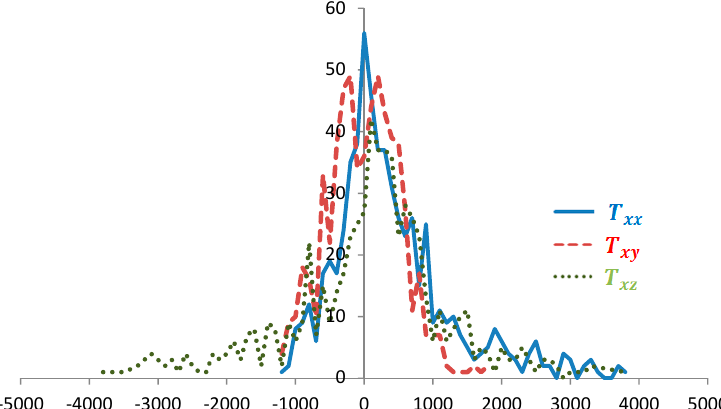
Figure 2. Distribution of points by g x for regions with low-amplitude, medium-amplitude, and high-amplitude gravity anomalies, mGal.